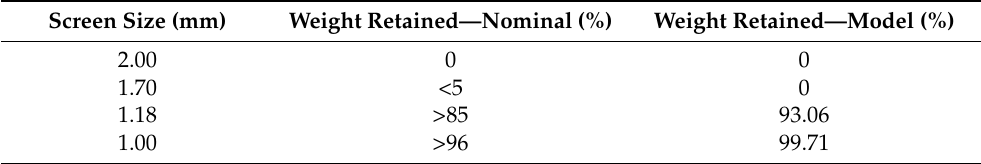
Table 1. Sieve analysis of the S460 shots and corresponding data of the modeled shots. Screen Size